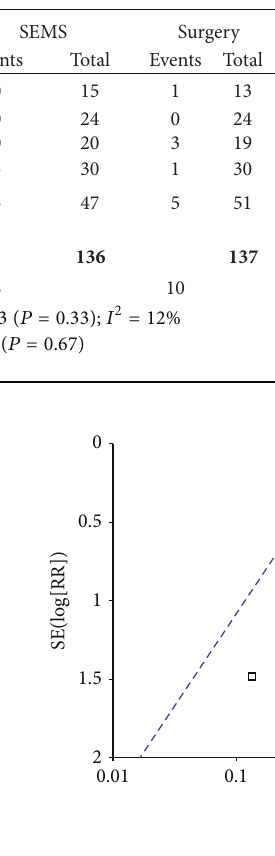
Figure 6: Forest plot and funnel plot of postoperative mortality within 30